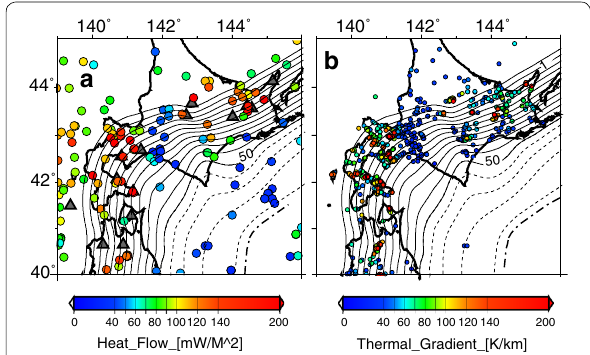
Fig. 7 Spatial distribution of data of a heat flow and b thermal gradient by Tanaka (2004). Color scales are shown at the bottom of the